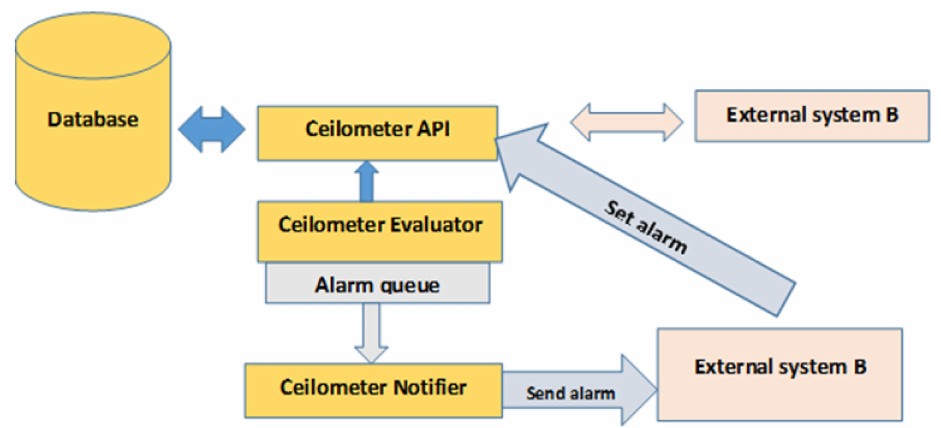
Figure 2. Creation and evaluation of alarms in